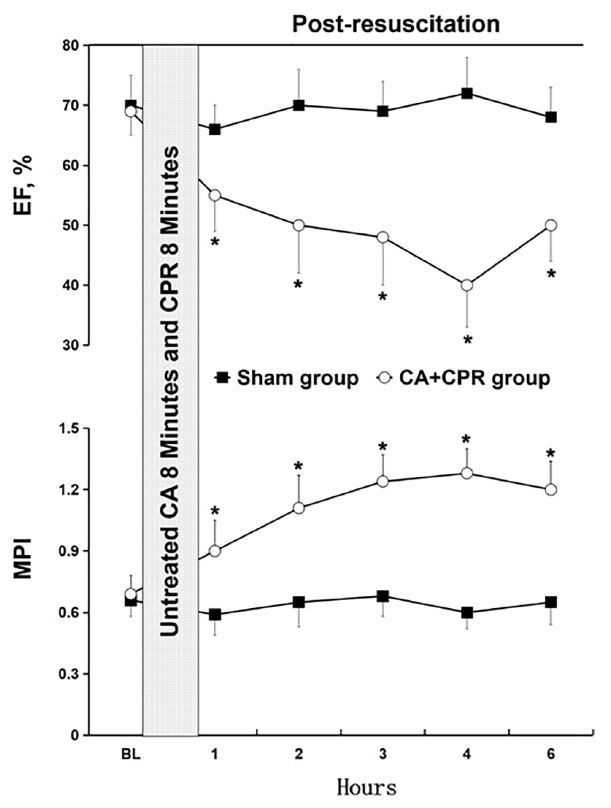
FIGURE 1 | Changes of the relevant indexes of myocardial dysfunction. BL, baseline; CA, cardiac arrest; CPR, cardiopulmonary resuscitation; EF, ejection fraction; MPI, myocardial performance index. * P < 0.05 vs. the sham group.